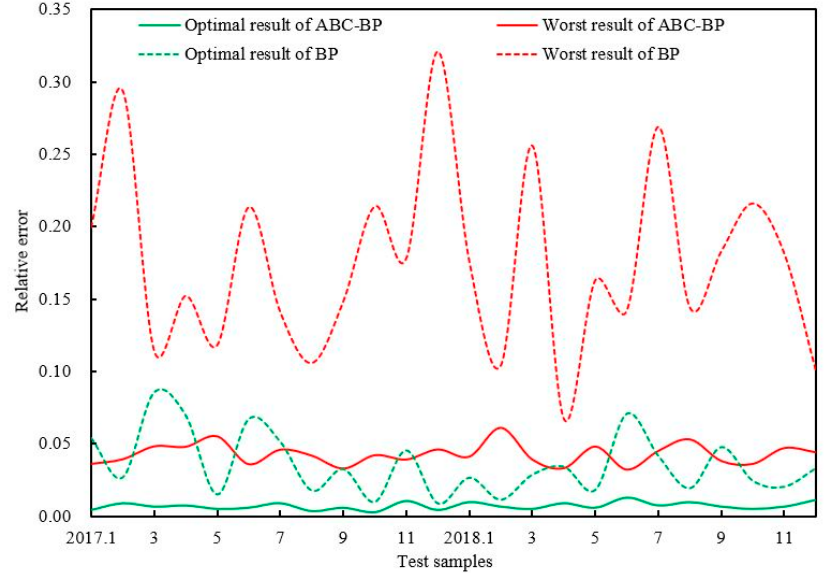
Figure 5. Comparison curves of the absolute value of RE between the optimal and worst training of the ABC-BP and BP models.